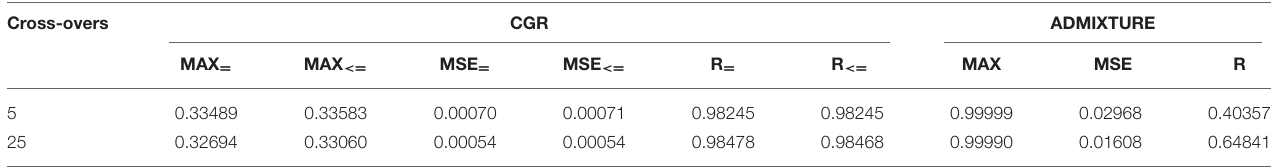
TABLE 4 | Statistic of the genome proportion estimation error for the human data set subject to the number of cross-overs when generating admixed individuals for CGR and ADMIXTURE. Cross-overs CGR ADMIXTURE